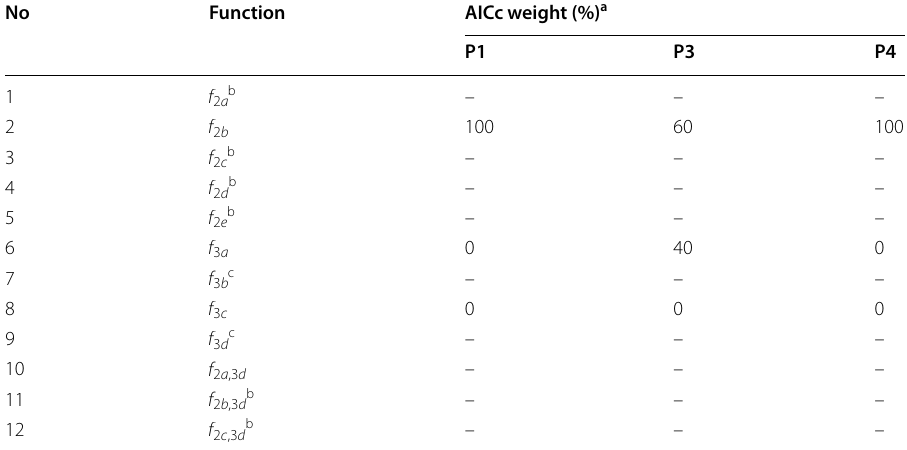
Table 2 AICc values and weights after applying the IBMS method in patients P1, P3 and P4